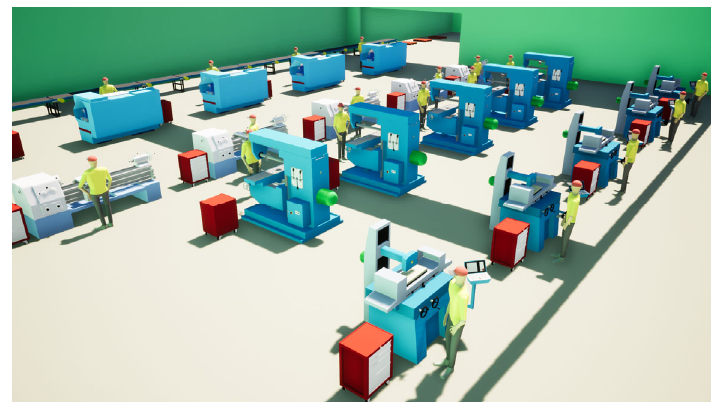
Figure 5. Visualization of a 3D production system model in a real environment.